Question: From the figure, is the trend upward or downward?
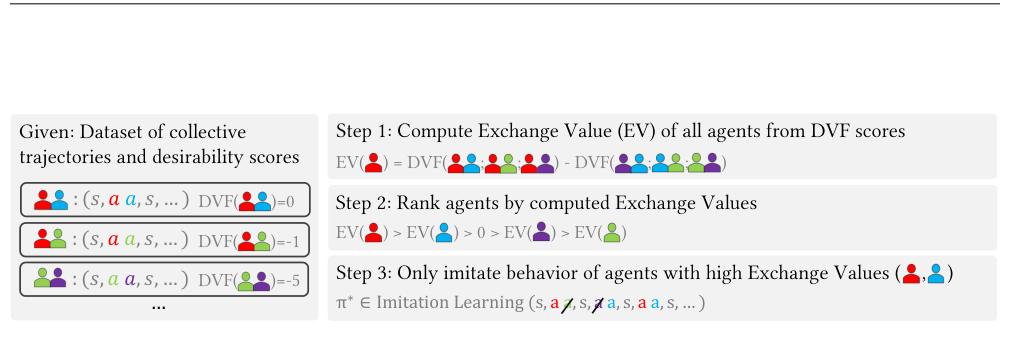
Answer: increasing